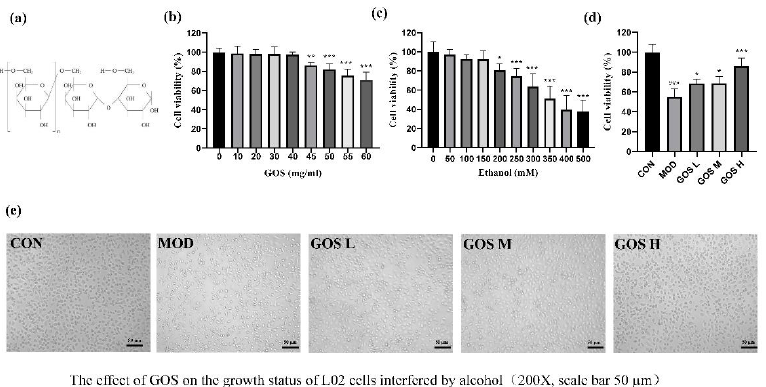
Figure 1. Chemical structure of GOS, screening of GOS administration concentration and alcohol- modeling concentration, effects of GOS on the viability of L02 cells treated with ethanol, and effects of GOS on the growth status of L02 cells treated with alcohol. ( a ) Chemical structure and formula of GOS. ( b ) Effects of different concentrations of GOS on cell viability ( n = 6, means ± SD). ( c ) Effects of different concentrations of ethanol on cell viability ( n = 6, means ± SD). ( d ) Effects of GOS on the viability of L02 cells treated with ethanol ( n = 6, mean ± SD). ( e ) The effect of GOS on the growth status of L02 cells treated with alcohol. Notes: Compared with the control (CON) group, ### p < 0.001; compared with the alcohol model control (MOD) group, * p < 0.05, ** p < 0.01, and *** p < 0.001.